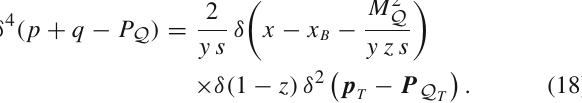
compared to (cid:2) 0 | O J